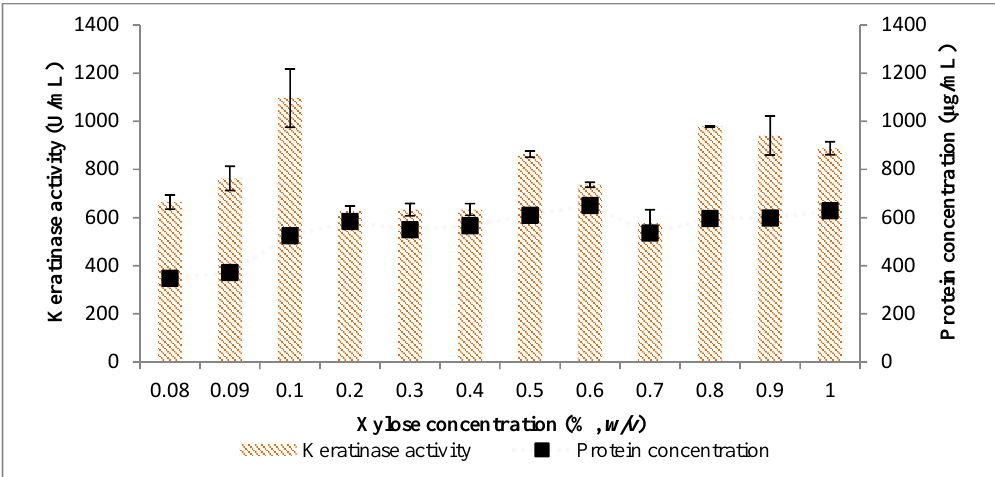
Figure 4. The effect of xylose concentrations on keratinase activity by Bacillus sp. FPF-1.